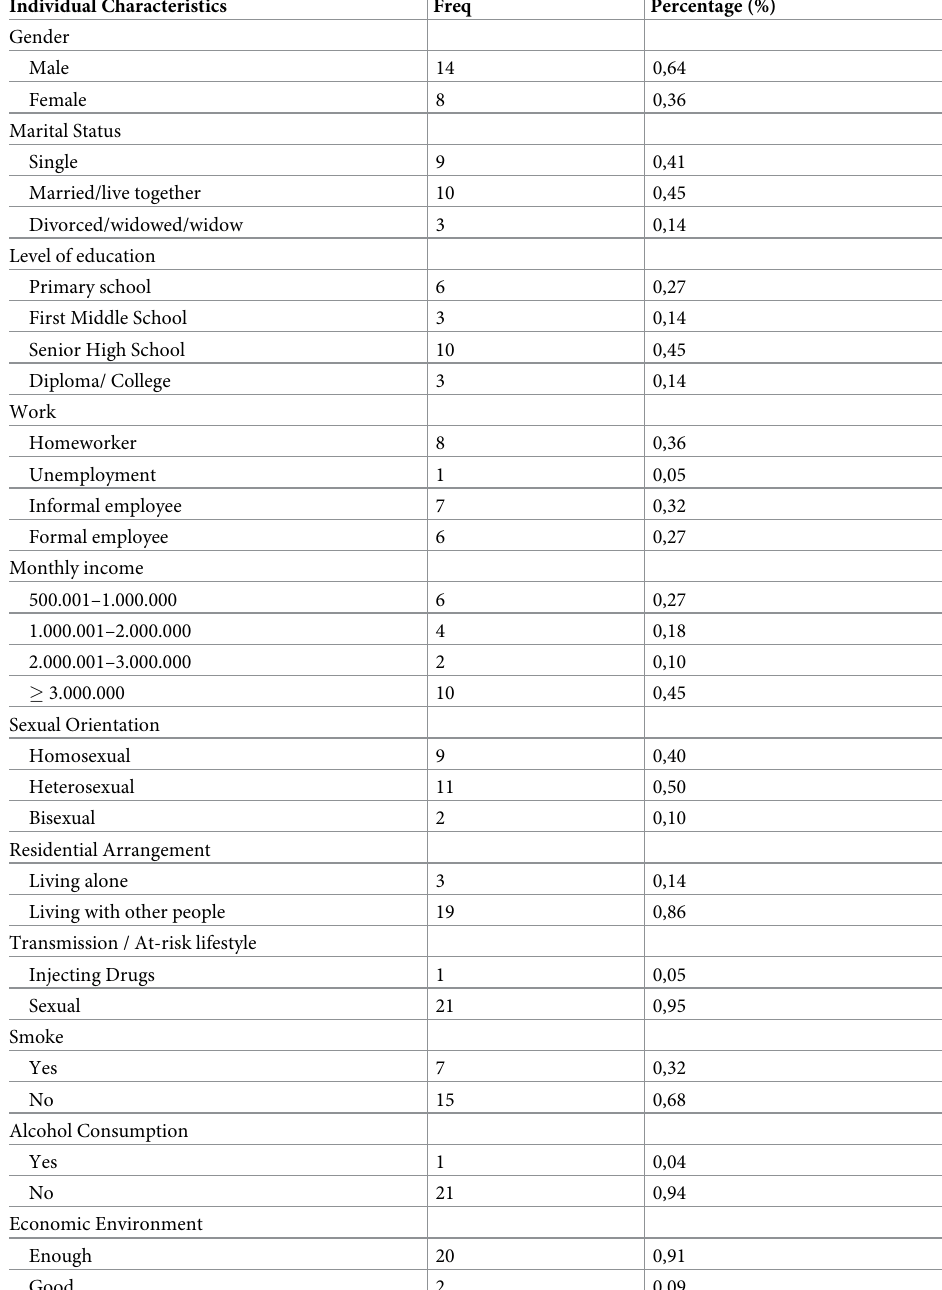
Table 1. Participants’ demographic